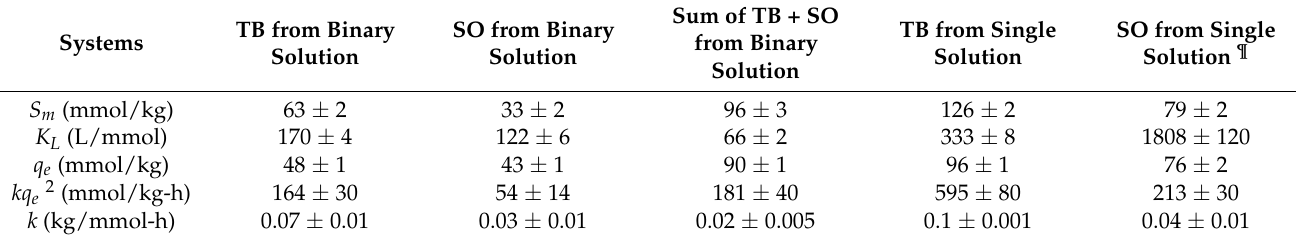
Table 1. Parameters of Langmuir and kinetic fits of TB and SO sorption on ZEO from single and binary solutions.